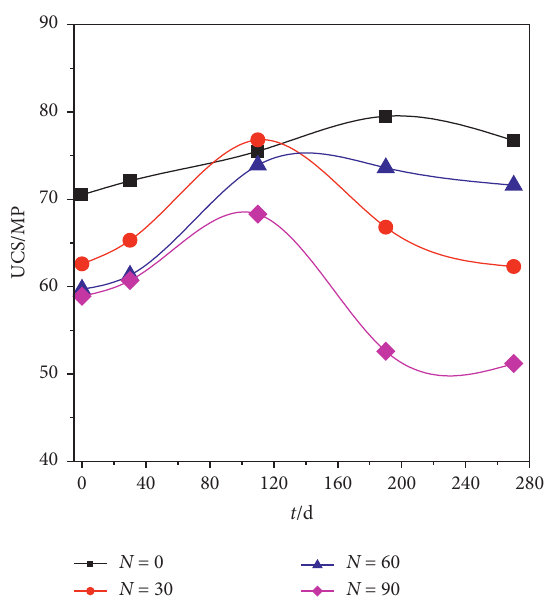
Figure 12: Curves of concrete strength σ c with the corrosion time after different freezing-thawing cycles.